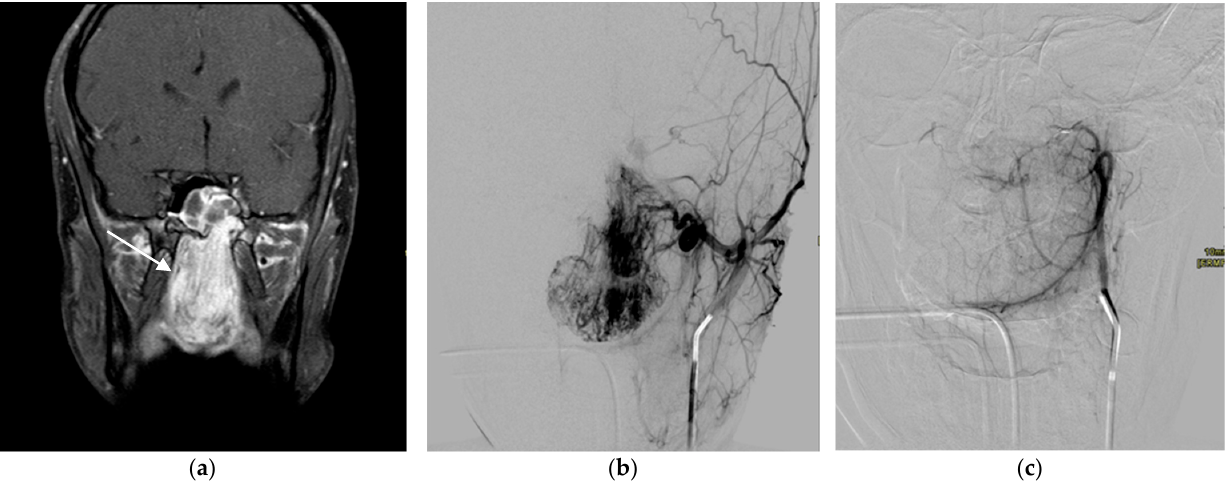
Figure 5. A 17-year-old male with juvenile nasopharyngeal angiofibroma (JNA). Preoperative em- bolization of JNA was performed. T1-weighed contrast-enhanced MRI sequence in the coronary plane shows JNA (arrow) that fills up most of the nasal cavity ( a ). Intraoperative DSA shows hyper- vascular tumor formation of the nasopharynx, nasal meatuses, and ethmoid cells ( b ).